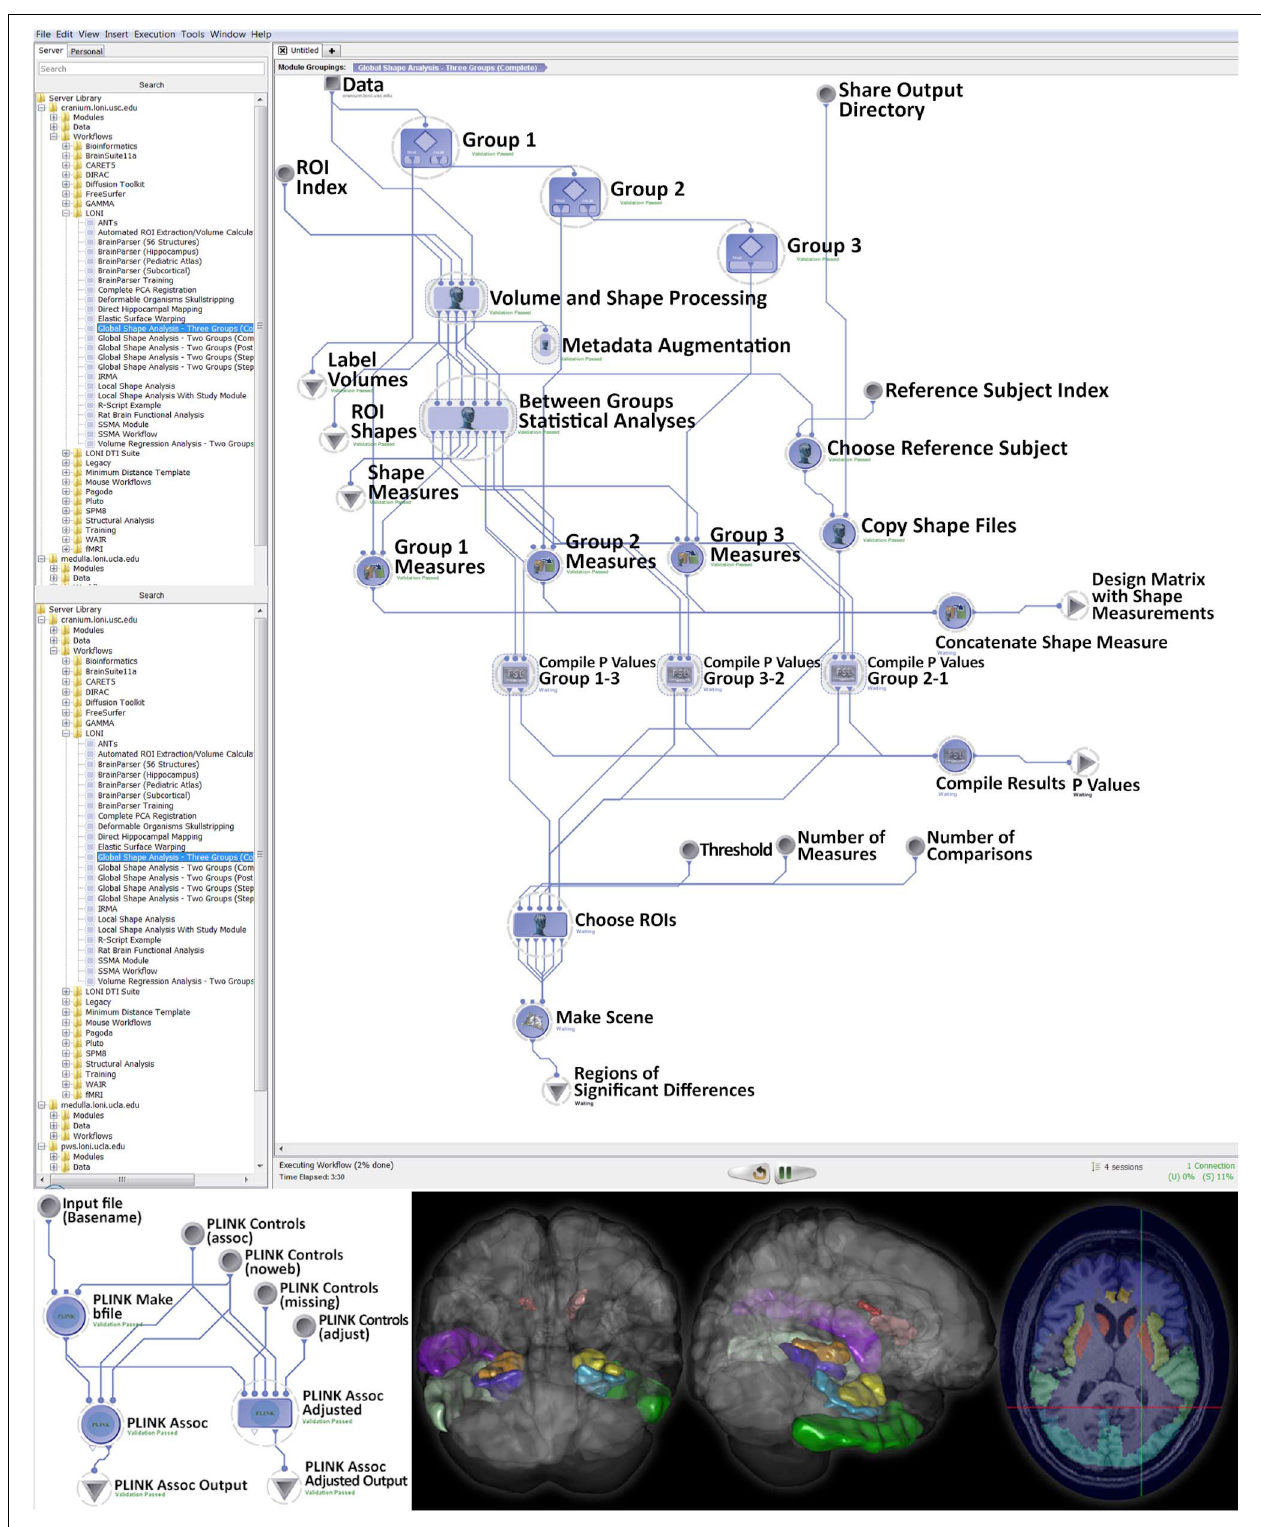
FIGURE 3 | Global shape analysis (GSA) protocol extracting neuroimaging biomarkers for each of the 3 cohorts (top), genetic phenotyping (bottom left), and examples of intermediate derived neuroimaging biometrics (bottom right).